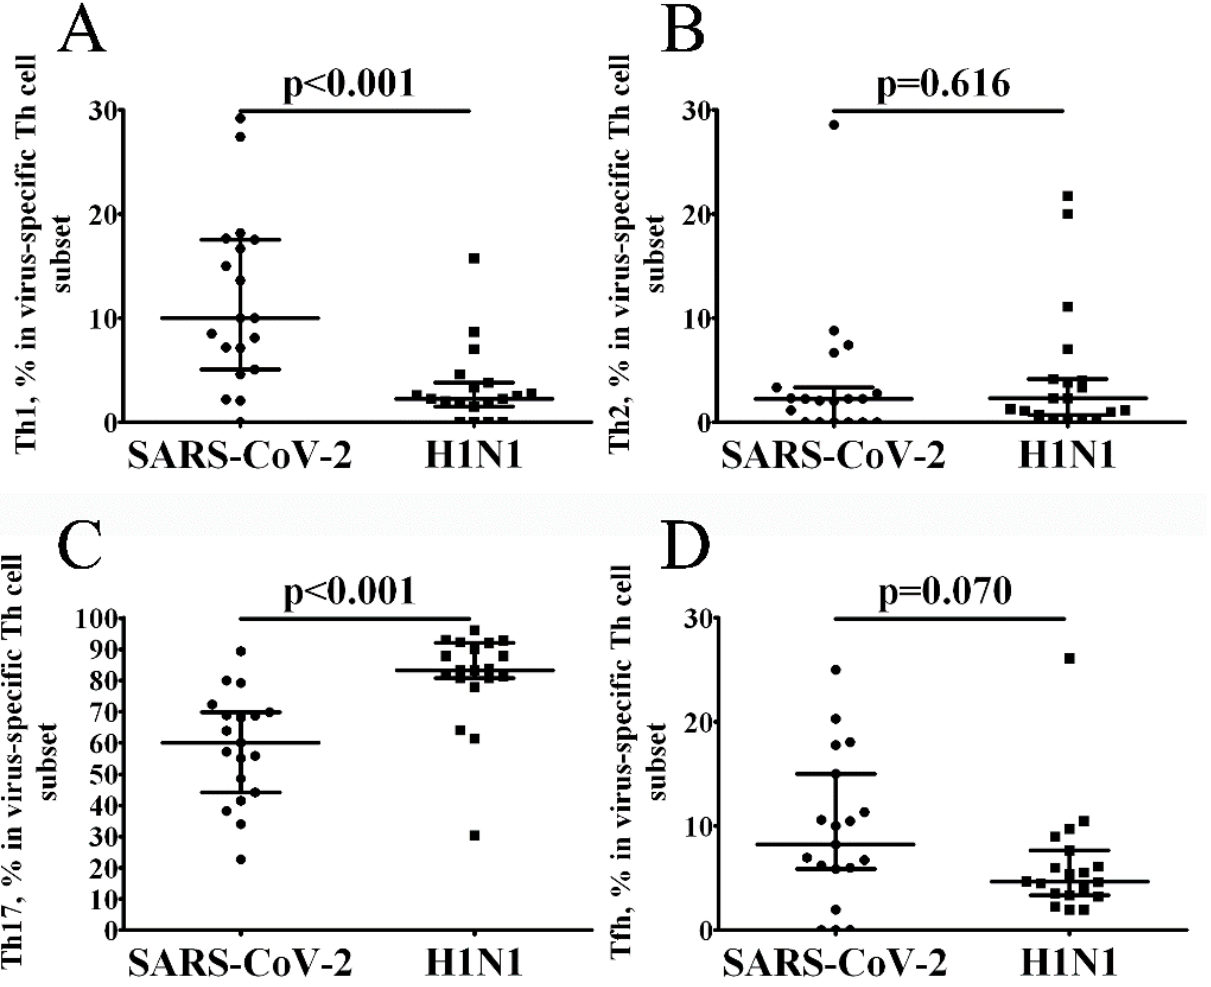
Figure 3. The functional polarization of circulating SARS-CoV-2- and H1N1-specific CD4+ T cells. Scatter plots A-D showing the percentages of Th1 (CXCR5–CCR6–CXCR3+CCR4–) ( A ), Th2 (CXCR5–CCR6–CXCR3–CCR4+) ( B ), Th17 (CXCR5–CCR6+) ( C ) and follicular Th (CXCR5+) ( D ) cells within the total virus-specific Th cell population, respectively. Black circles—SARS-CoV-2-specific CD4+ T cells ( n = 19); black squares—H1N1-specific CD4+ T cells. Each dot represents individual subjects, and horizontal bars represent the group medians and quartile ranges (Med (Q25; Q75). A statistical analysis was performed with a Mann-Whitney U test.